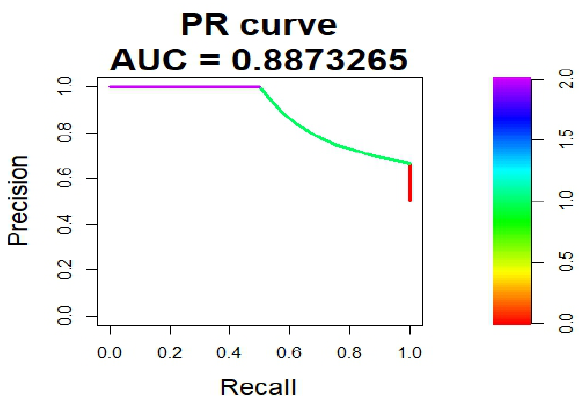
Figure 13. Area under PR curve for SVM